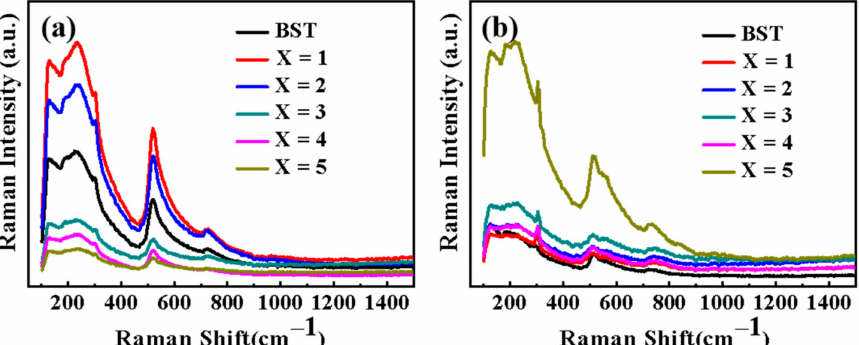
Figure 5. ( a ) Room-temperature Raman spectroscopy results for BST and BST-x mol% MgO (x = 1, 2, 3, 4, 5) powders. ( b ) Room-temperature Raman spectroscopy results for BST and BST-x mol% MgO (x = 1, 2, 3, 4, 5)